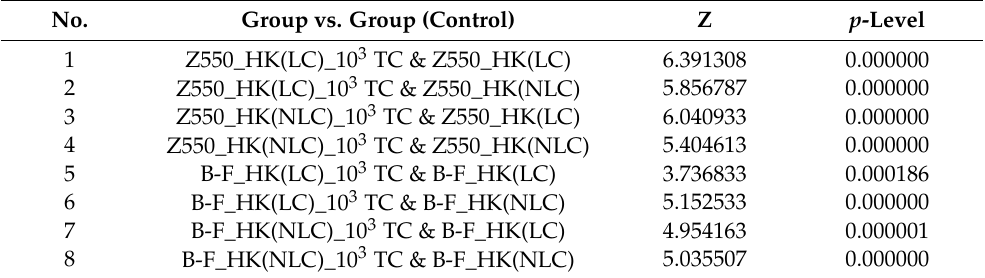
Table 3. Wilcoxon test results. The significance of the differences in the microhardness of the aged specimens for one month and the specimens exposed to thermocycling. LC—light-cured surface of sample (top side of sample), NLC—non-light-cured surface (bottom side of sample), HK—Knoop hardness. No. Group vs. Group (Control) Z p -Level 1 Z550_HK(LC)_10 3 TC & Z550_HK(LC)